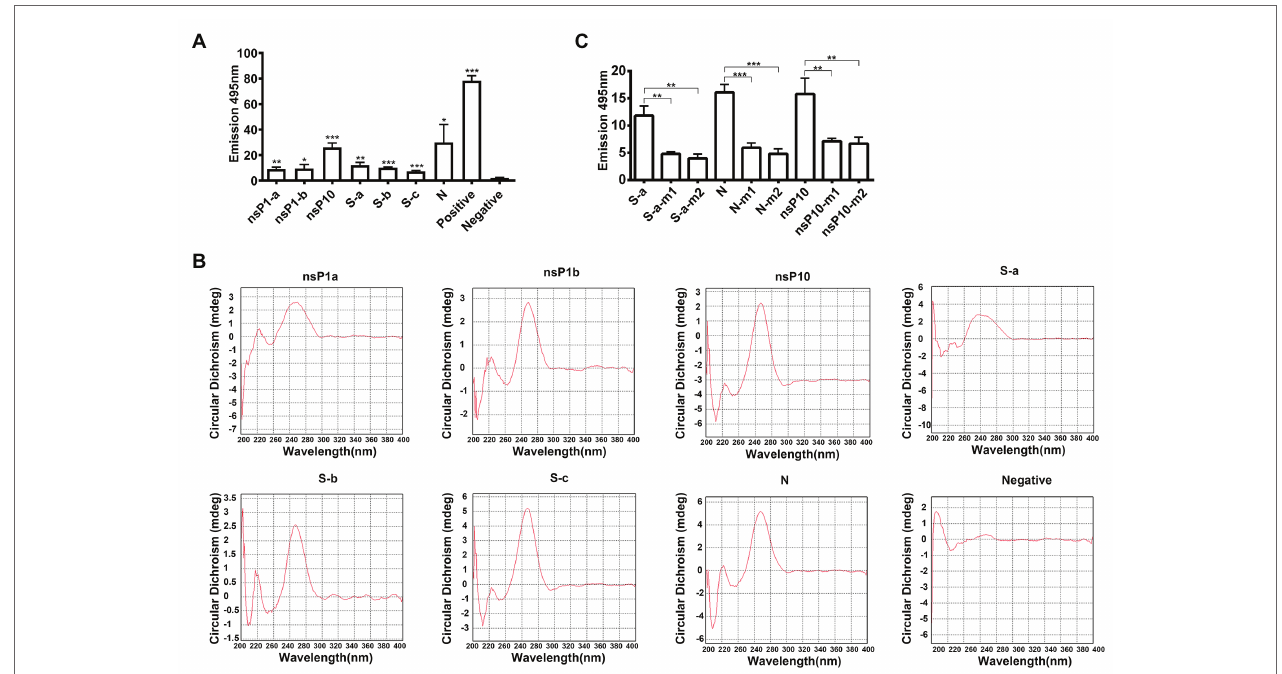
FIGURE 3 | Characterization of G-quadruplex structures. (A) Thioflavin T (ThT) fluorescence assay for each conserved G-quadruplex sequences. * p < 0.05, ** p < 0.01, and *** p < 0.001 based on the Student t -test. All results are from three independent experiments. Error bars, SD. (B) Circular dichroism (CD) spectrum of conserved G-quadruplex sequences. (C) ThT fluorescence assay for G-quadruplex single or double mutations. m1, single guanine mutation; m2, double guanines mutation. * p < 0.05, ** p < 0.01, and *** p < 0.001 based on the Student t -test. All results are from three independent experiments. Error bars, SD.